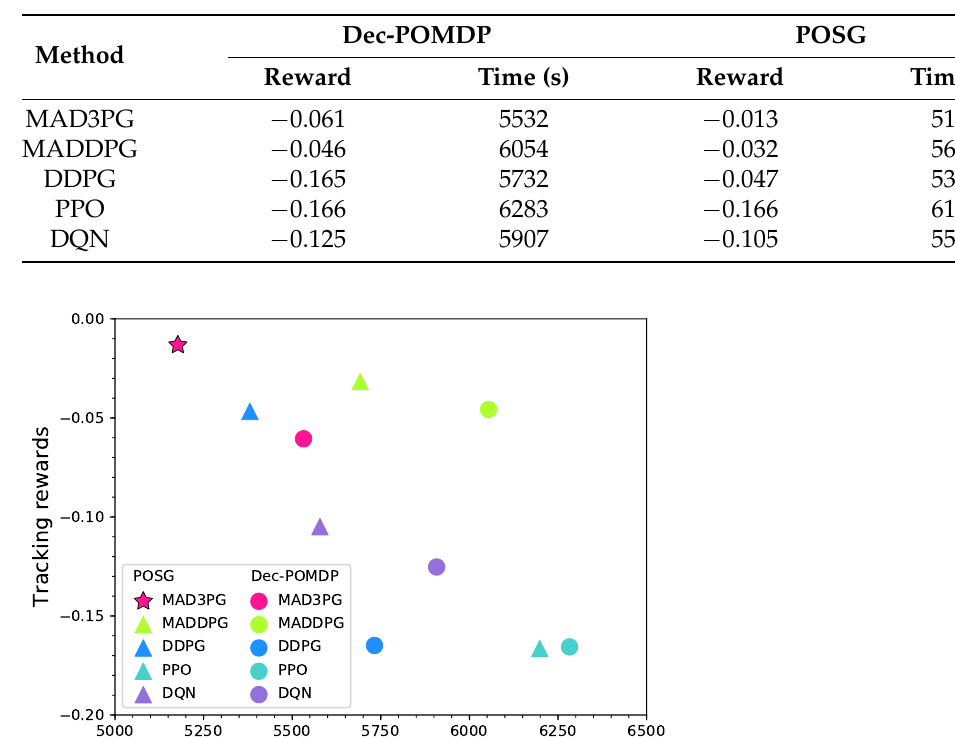
Table 3. Results of the tracking rewards and the time cost.